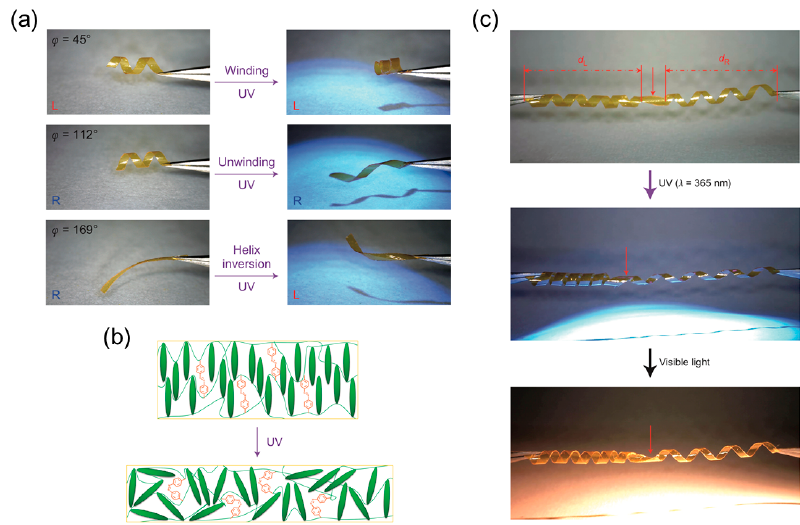
Figure 7. Light-induced helical motion of a LCN ribbon. ( a ) Change in pitch and inversion of handedness of spiral ribbons cut at different angles ( φ ) irradiated by UV light; ( b ) Anisotropic deformation at the molecular level: shrinkage along the director and expansion in the direction perpendicular to the director; ( c ) A proof-of-principle for an actuator capable of performing complex motion: the kink in the middle connecting helices of opposite handedness shows a smooth push-pull motion. Figure reprinted from [38] by permission of Springer Nature.